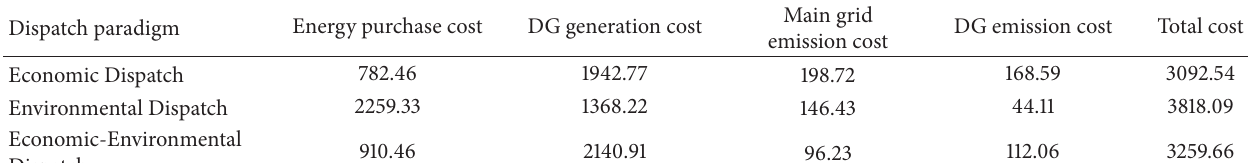
Table 4: Optimization results under different MG scheduling paradigms.